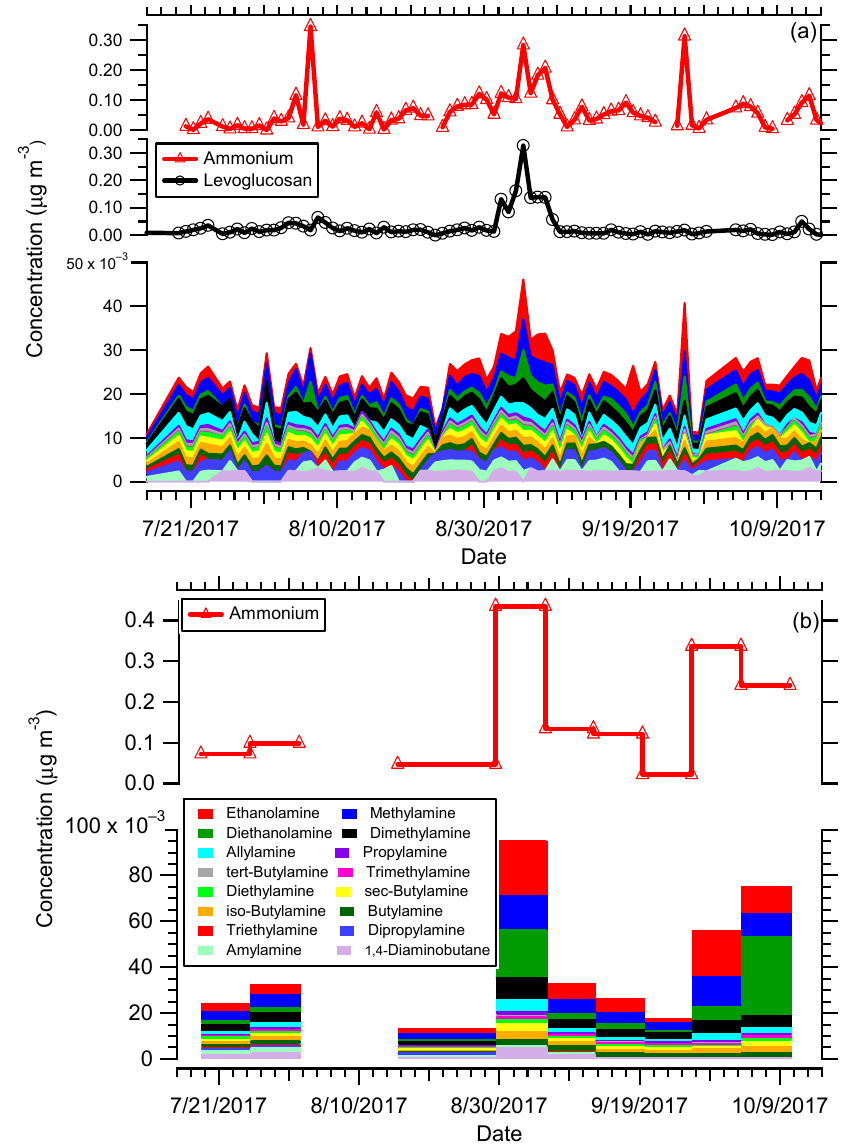
Figure 6. ( a ) Times series of levoglucosan, ammonium, and amines measured from daily filter samples collected at RMNP and ( b ) ammonium, and amines measured from weekly filter samples collected at Greeley, CO from 15 July to 15 October